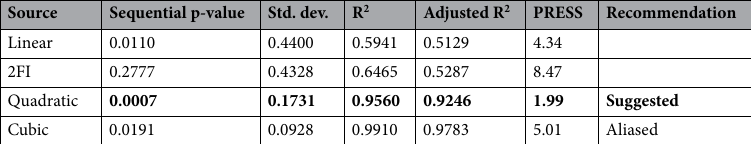
Table 15. Model summary statistics of voids zone for QAM f steel. Significant values are in bold.